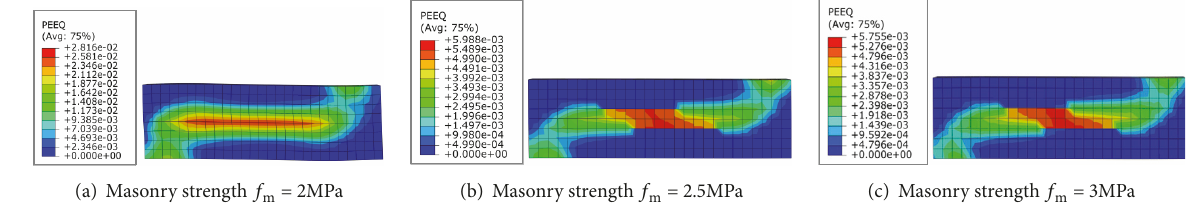
Figure 17: Plastic strain in infill walls.